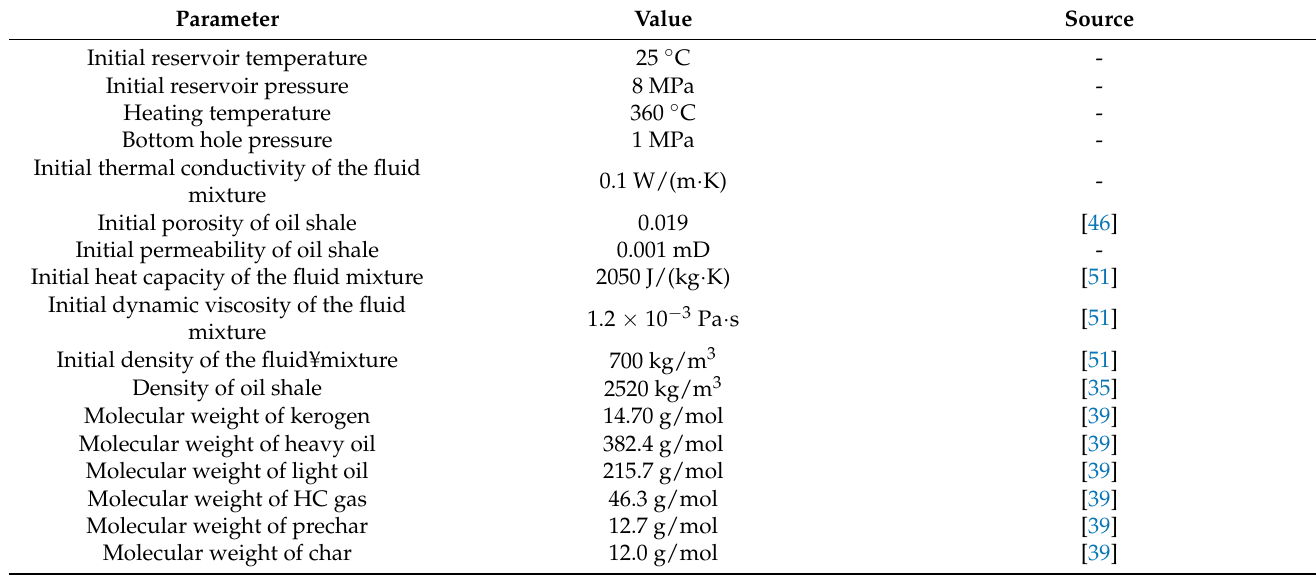
Table 2. Parameters used in the